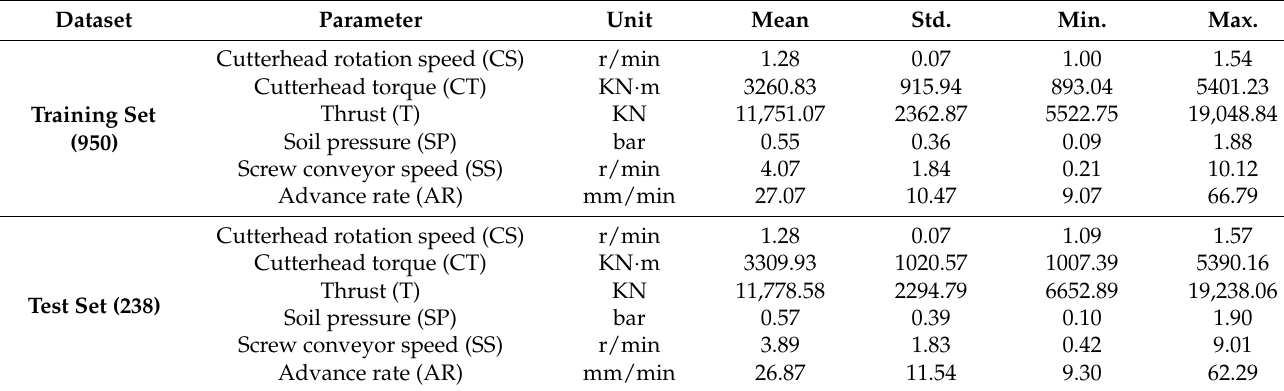
Table 3. Brief description of operational parameters.